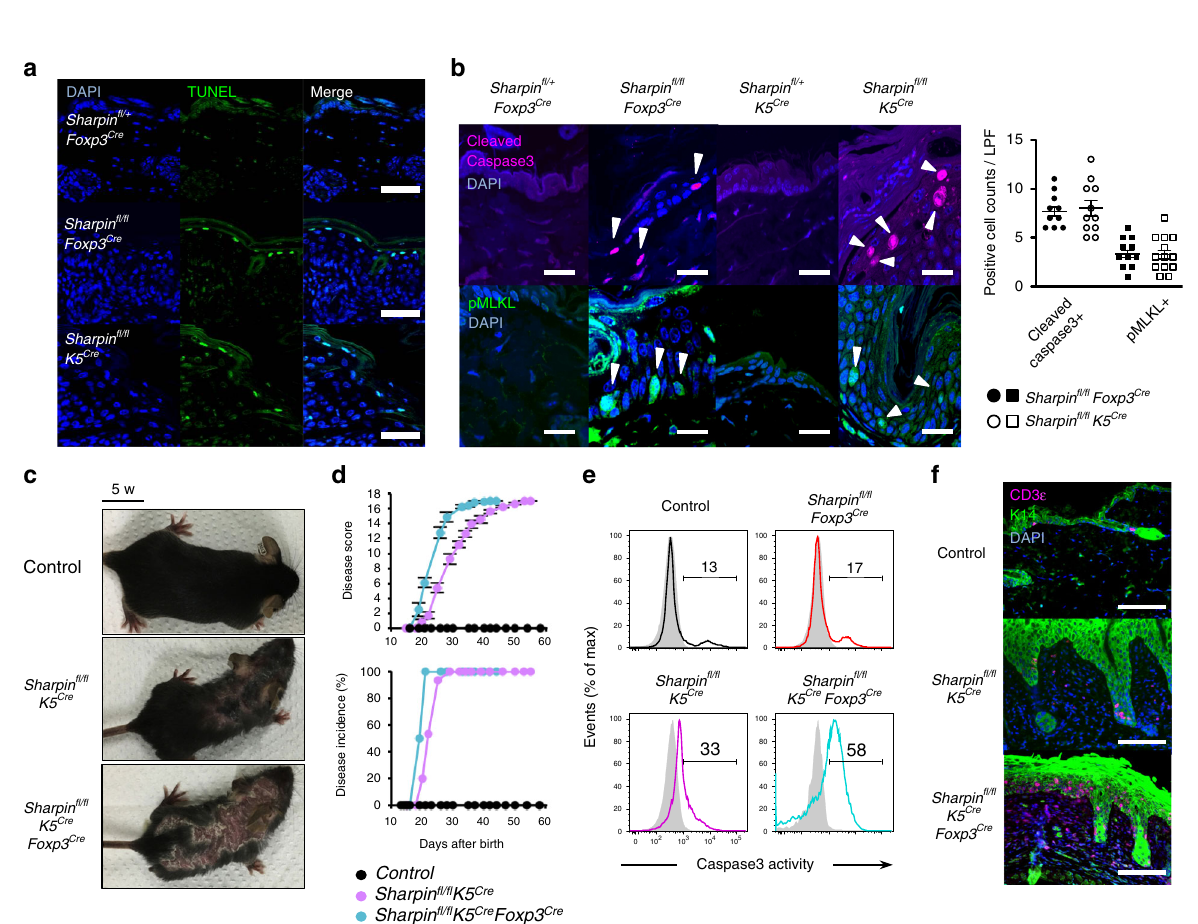
Fig. 5 Skin-oriented T cells induce apoptotic and necroptotic keratinocyte death in an in fl ammatory setting. a TUNEL staining of skin sections from 5-week- old Sharpin fl / fl K5 Cre , 10-week-old Sharpin fl / fl Foxp3 Cre , and control mice. Scale bars: 50 μ m. b Immuno fl uorescence staining of skin sections. Cleaved caspase- 3 and phosphorylated MLKL were used as markers of apoptosis and necroptosis, respectively. Scale bars: 20 μ m. Cell death in the epidermis was quanti fi ed by counting the total number of bright cells per low-power fi eld (LPF). c Appearance of skin dermatitis. d Progression (upper) and incidence (lower) of skin disease among the indicated strains (numbers of mice: control, n = 12; Sharpin fl / fl K5 Cre , n = 15; Sharpin fl / fl K5 Cre Foxp3 Cre , n = 8). Disease scores were recorded up to 60 days after birth. No gender-based differences in the incidence of skin disease were observed. e Representative histogram showing death- prone epidermal cells from the indicated strains. Isolated epidermal cells were incubated with PhiPhiLux-G 1 D 2 , a fl uorescent substrate of active caspase-3. f Immuno fl uorescence staining of skin sections to detect skin-in fi ltrating T cells. Scale bars: 100 μ m. The small horizontal lines in b , d indicate the mean (±s.e.m.). Data are representative of at least three independent experiments. Source data are provided in a Source Data fi (Fig. 5c – e). Moreover, a massive T cell in fi ltrate was observed of Sharpin fl / fl Foxp3 Cre mice; indeed, the phenomena were in the skin of Sharpin fl / fl K5 Cre Foxp3 Cre mice (Fig. 5f). Collec- almost as common in these mice as in Sharpin fl / fl K5 Cre mice (Fig. 5a, b). Additional elimination of Sharpin from Treg in tively, these results strongly suggest that skin-oriented acti- Sharpin fl / fl K5 Cre mice ( Sharpin fl / fl K5 Cre Foxp3 Cre ) exacerbated vated T cells promote keratinocyte death and induce skin autoin fl ammation, and that induction of cell death underlies T skin in fl ammation, with a marked increase in caspase-3 activity cell-mediated in fl ammatory processes. in CD45 neg keratinocytes, which led to earlier onset of disease